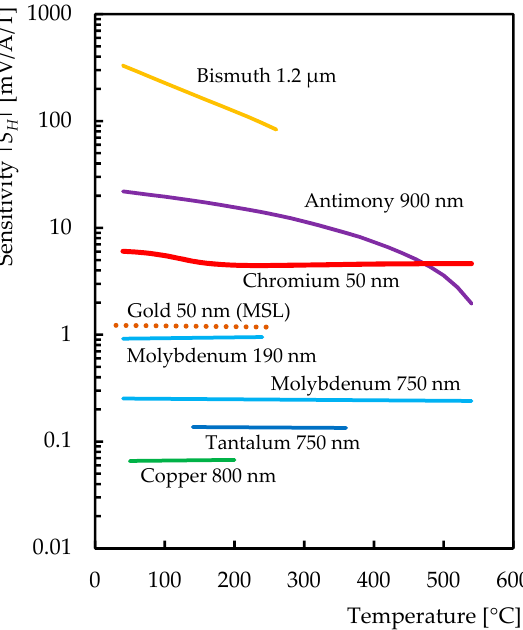
Figure 10. Sensitivity of the semimetal and metal Hall sensors tested so far [23].